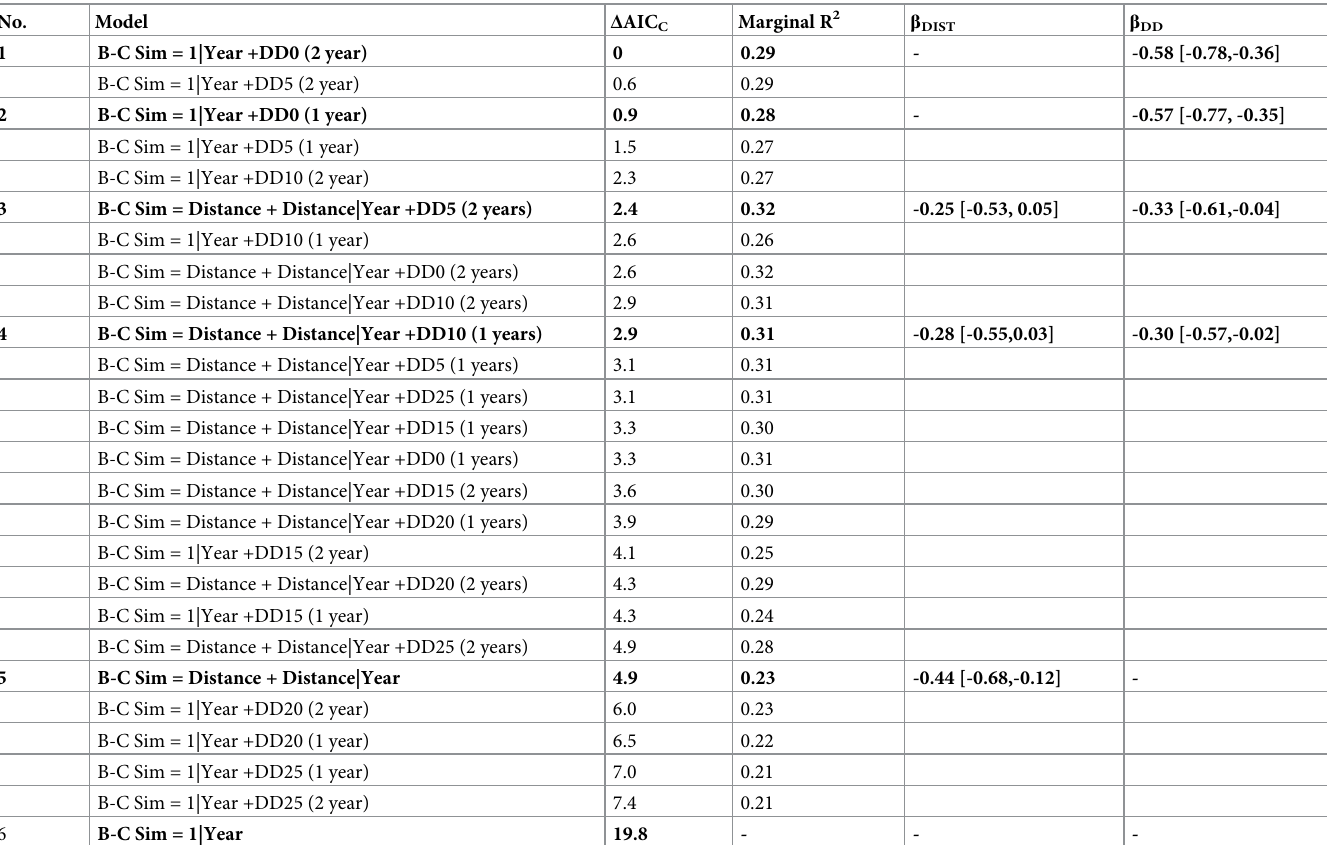
Table 3. Results of model selection procedure. Distance refers to the physical distance (in river km) between pools, while DD refers to the difference in degree days between pools over the previous 1 or 2 years. Threshold temperatures of 0˚C, 5˚C, 10˚C, 15˚C, 20˚C and 25˚C were compared, but only the threshold with the strongest support (assessed with AIC C ) was parameterized for these purposes ( bolded models ). For example, if a model with DD0 had a lower Δ AIC C than an otherwise identical model with DD5, we only parameterized the model with DD0. B-C Sim = Bray-Curtis similarity; β DIST = standardized slope relating distance to B-C Sim; β DD = standard- ized slope relating difference in degree days to B-C Sim. Because temperature data are relatively limited, only 72 observations were included in this